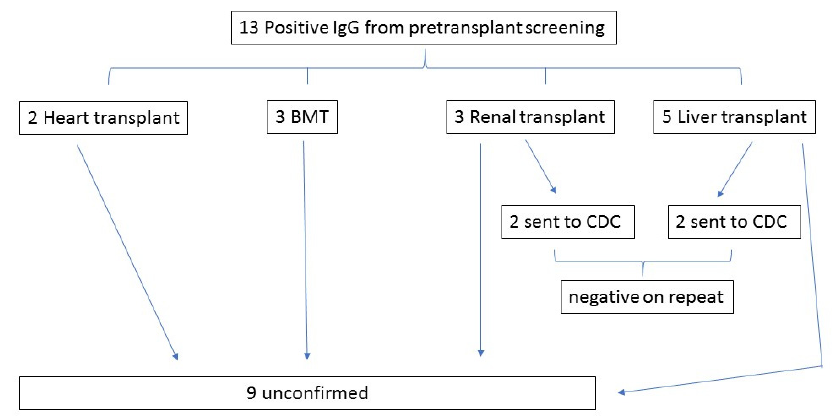
Figure 2. Follow up of pretransplant screening